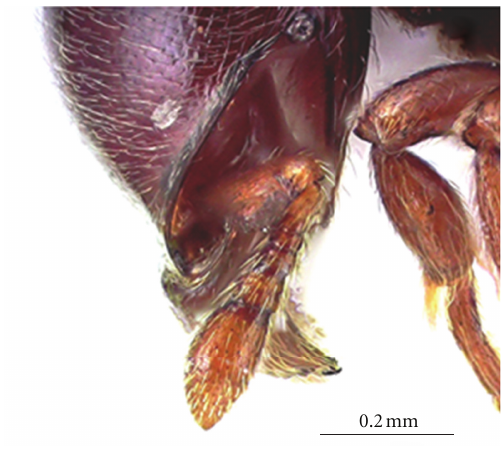
Figure 3: Tatuidris kapasi : holotype worker. Detail of head: left side view.